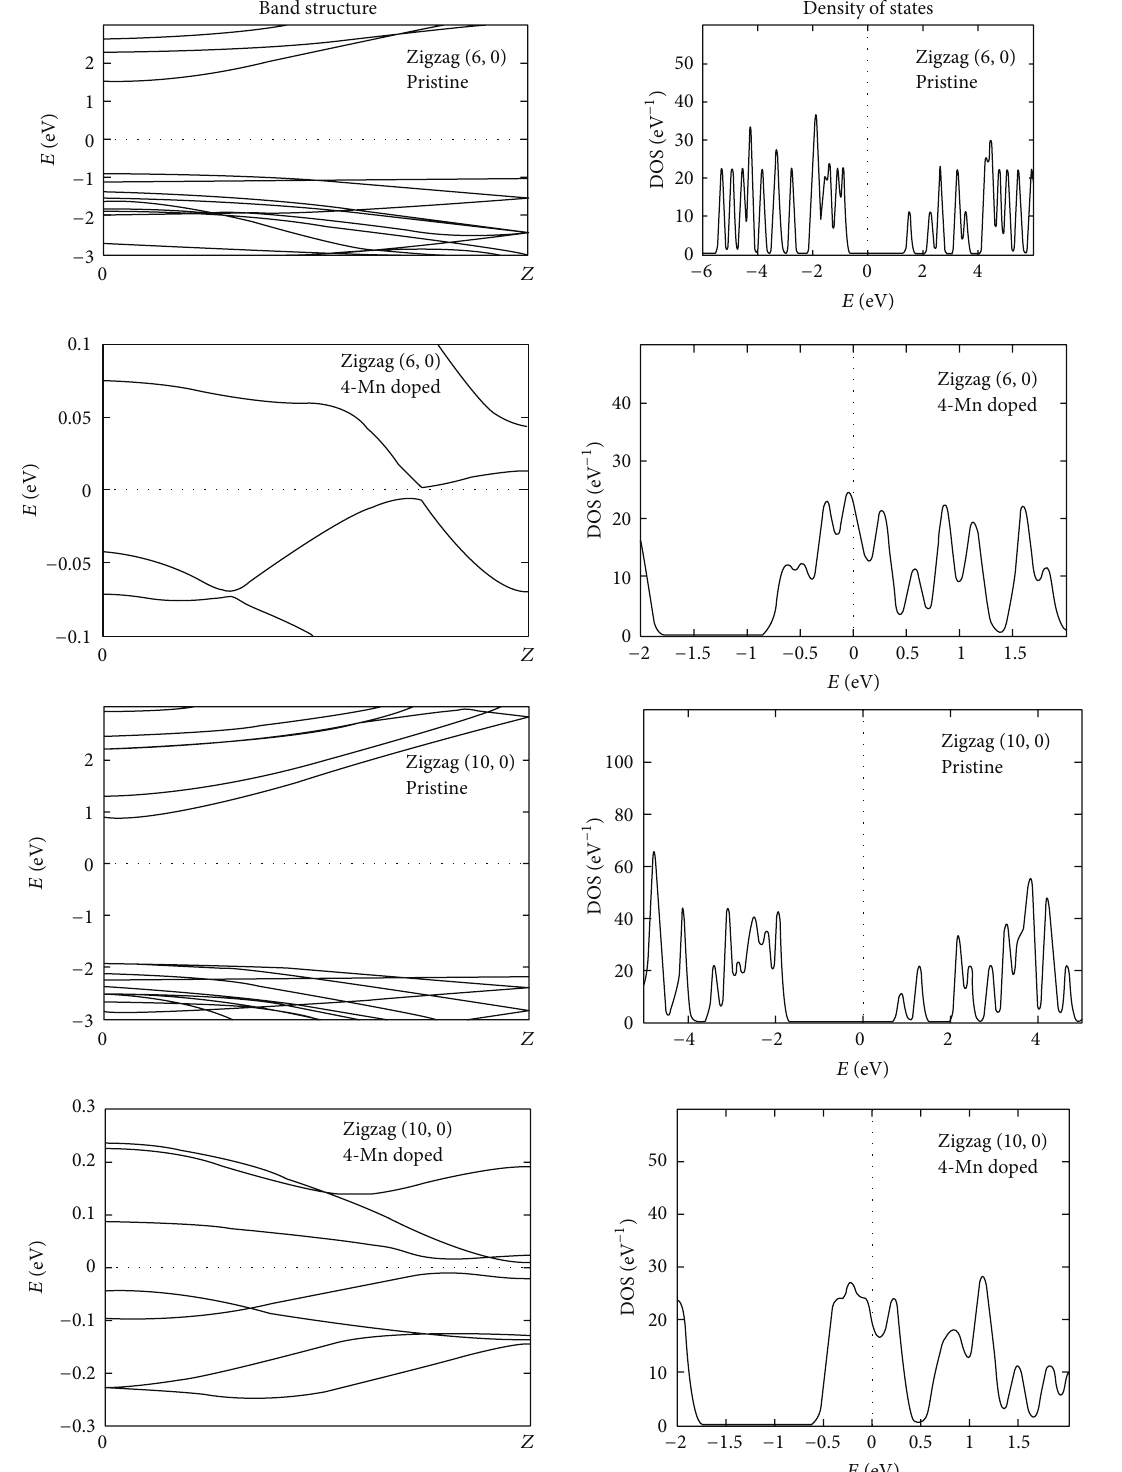
Figure 6: The band structure and density of states profile of pristine and Mn doped zigzag (6, 0) and (10, 0) GaN